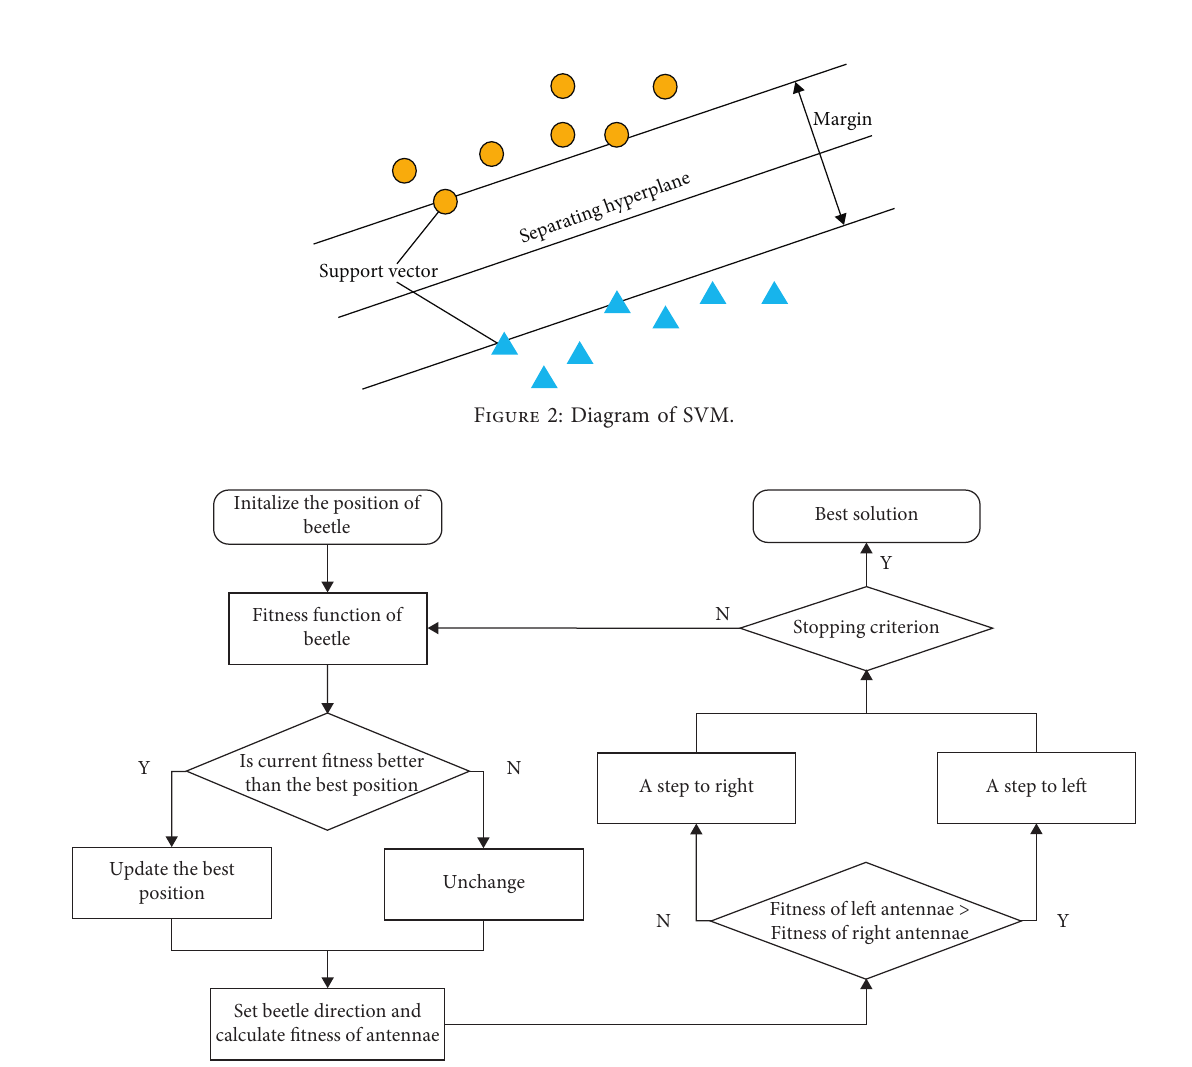
Figure 3: Flow chart of